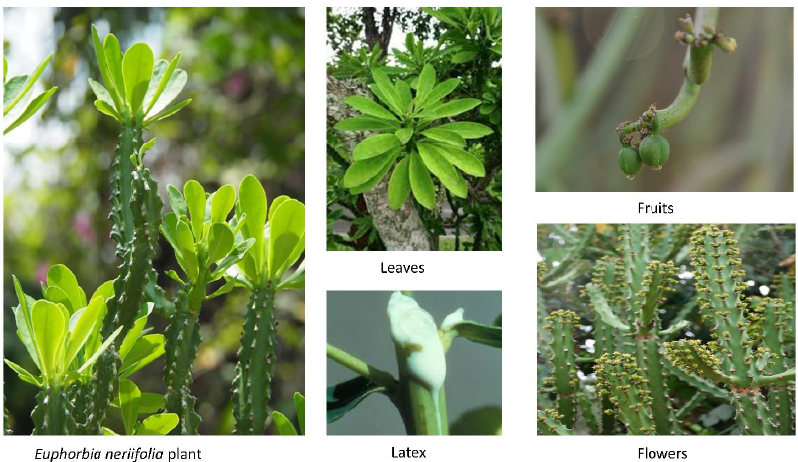
Figure 1. Different parts (leaves, latex, fruits, and flowers) of the Euphorbia neriifolia